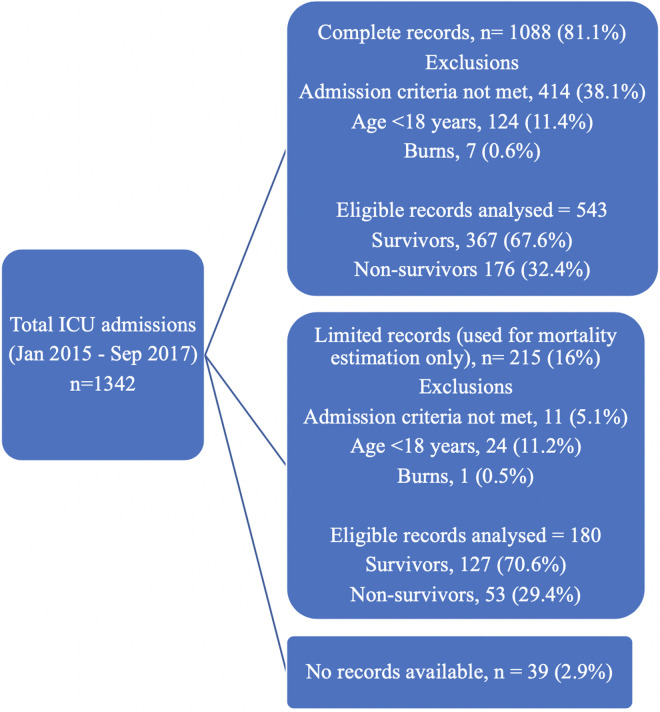
CONSORT diagram.